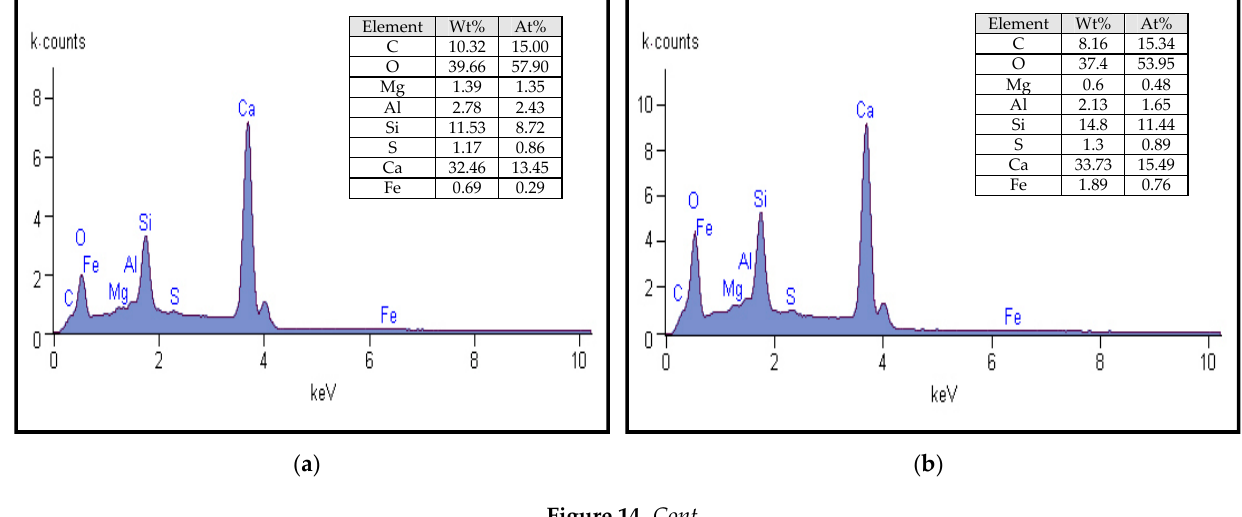
( d ) Figure 14. EDX analysis for healing compounds at 28 days for 100%OPC (up) and 95%OPC + 5%SF (down) ( a ) 100%OPC without capsules, ( b ) 100%OPC with capsules, ( c ) 95%OPC + 5%SF without capsule, ( d ) 95%OPC + 5%SF with capsule. 6. Conclusions An important aspect of the encapsulation method for self-healing application in a cement-based application is the compatibility of the capsule within the cement matrix and also the self-healing effects. From the observed results and discussions, the modified cap- sule is proposed based on the following conclusions below.